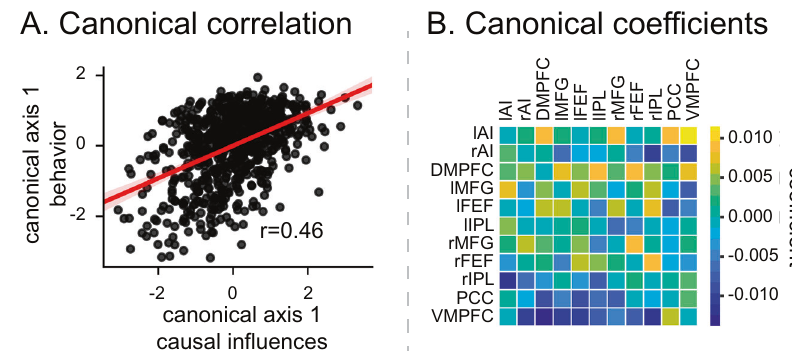
Fig. 6 Dynamic causal in fl uence relation to behavioral performance. A Canonical correlation analysis revealed a signi fi cant relationship between directed SN, FPN, and DMN causal in fl uences and behavioral performance in the 2-back working-memory task condition ( r = 0.46, p < 0.001, Pearson ’ s correlation). B Correlation coef fi cients contributing to brain-behavior relations highlights positive in fl uences between SN and FPN nodes and negative in fl uences of SN and FPN nodes on PCC and VMPFC nodes of the DMN. lAI left anterior insula, rAI right anterior insula, DMPFC dorsomedial prefrontal cortex, lMFG left middle frontal gyrus, rMFG right middle frontal gyrus, lFEF left frontal eye fi eld, rFEF right frontal eye fi eld, lIPL left intraparietal lobule, rIPL right intraparietal lobule, PCC posterior cingulate cortex, VMPFC ventromedial prefrontal cortex. Source data are provided as a Source data fi